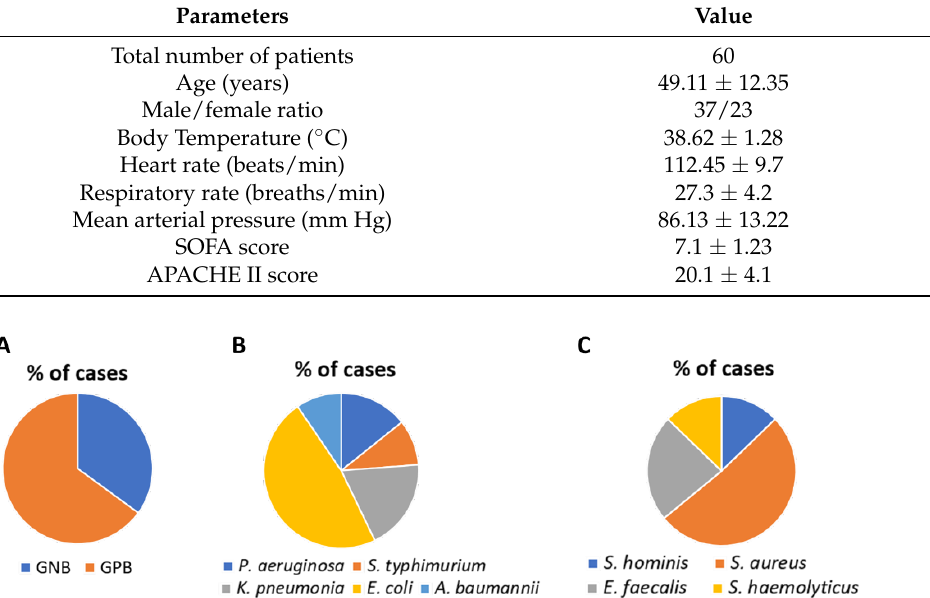
Figure 1. ( A ) Pie chart showing the percentage of GNB and GPB present out of the total cases. ( B ) Pie chart showing the percentage of GNB E. coli , P. aeruginosa , A. baumannii , K. pneumoniae , and S. typhimurium . ( C ) Pie chart showing the percentage of GPB S. aureus , E. faecalis , S. haemolyticus , and S. hominis .